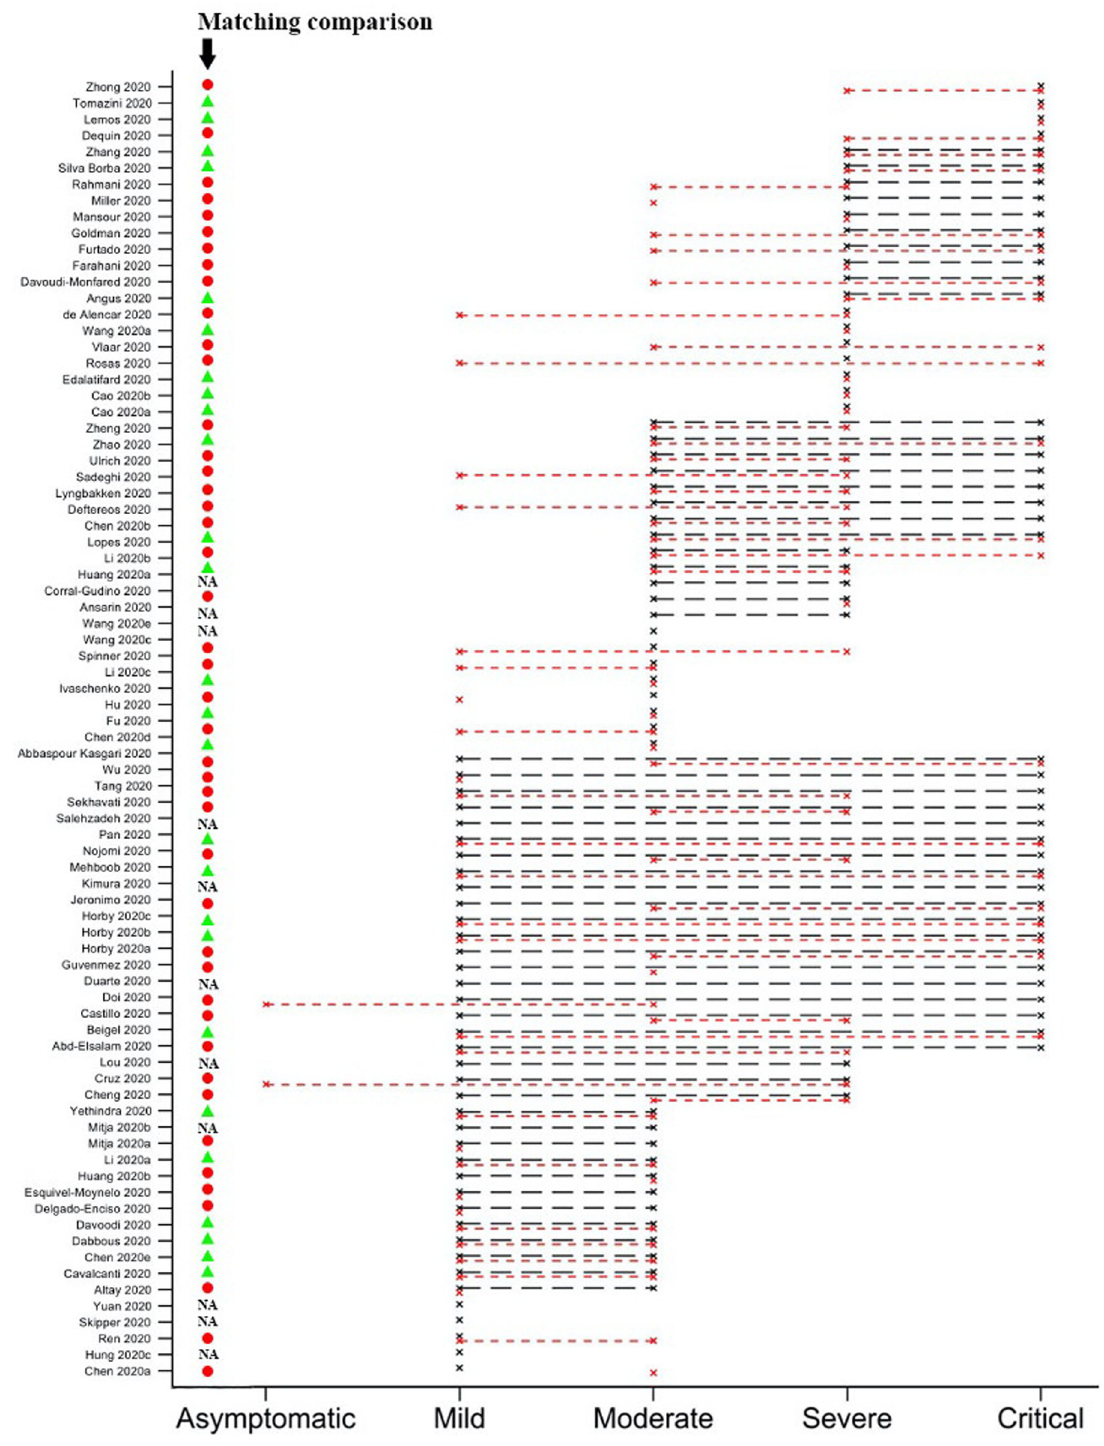
Fig 2. Possible range of patient severity in studies as classified by WHO- COVID-19 Living Network Meta-Analysis group (black circles) and COVID-NMA initiative (red squares). Matched severity definiton between the two groups (green triangle), unmatched (red